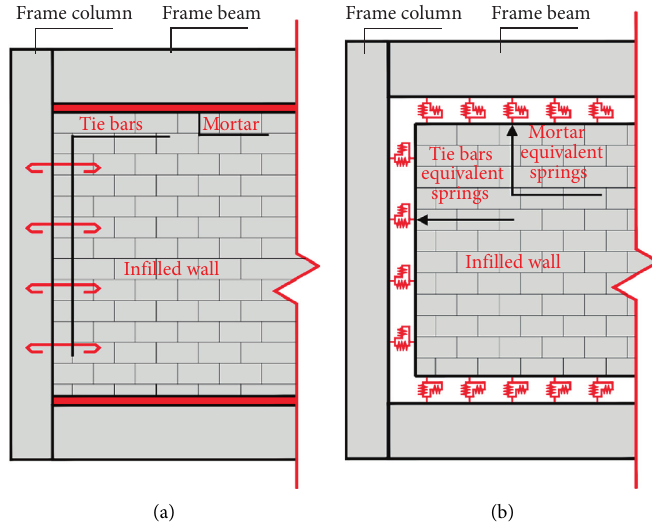
Figure 14: Structural and equivalent calculation diagram of frame infilled wall. (a) Structural drawing. (b) Equivalent drawing.